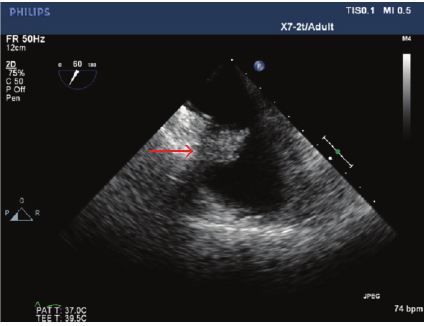
Figure 3: It shows organized